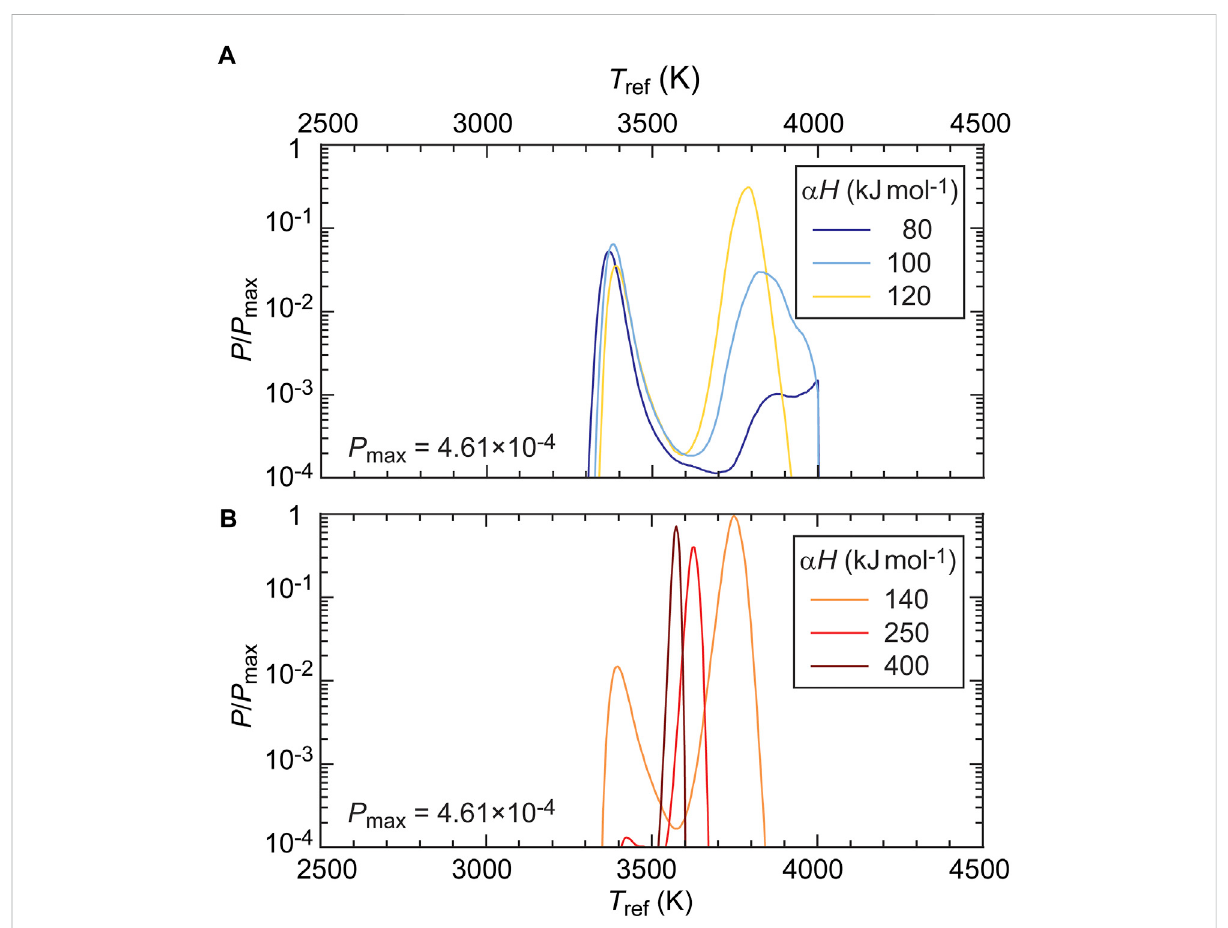
Totallikelihood,de fi nedastheproductoftheindividuallikelihoodateachlocation(Eq.9),asafunctionofthereferencetemperature T ref andfor severalvaluesoftheproductofthefrequencyexponent α andactivationenthalpy H :80,100,and120kJmol − 1 (A) ;and140,250,and400kJmol − 1 (B) . Total likelihoods are normalized with the absolute maximum, P max , and plotted with a logarithmic scale. The temperature of the transition to pPv is T pPv = 3500 K. For other details of the calculations, see text and Table